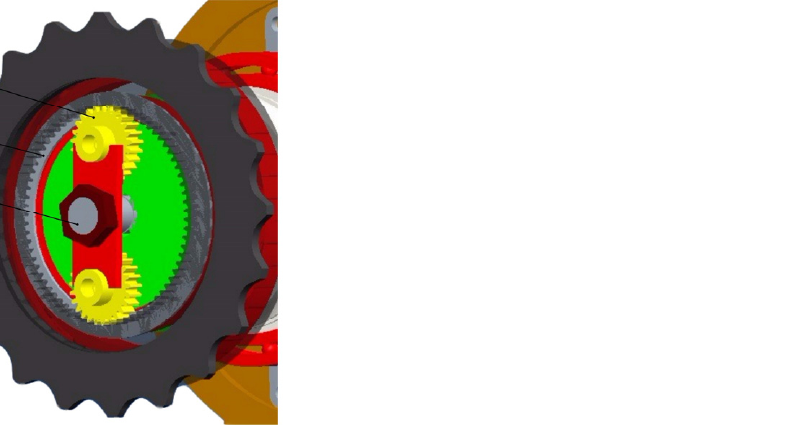
Figure 7. Differential wheel mechanism 3D model. 1. Planetary wheel; 2. Inner gear ring; 3. Sprocket shaft.